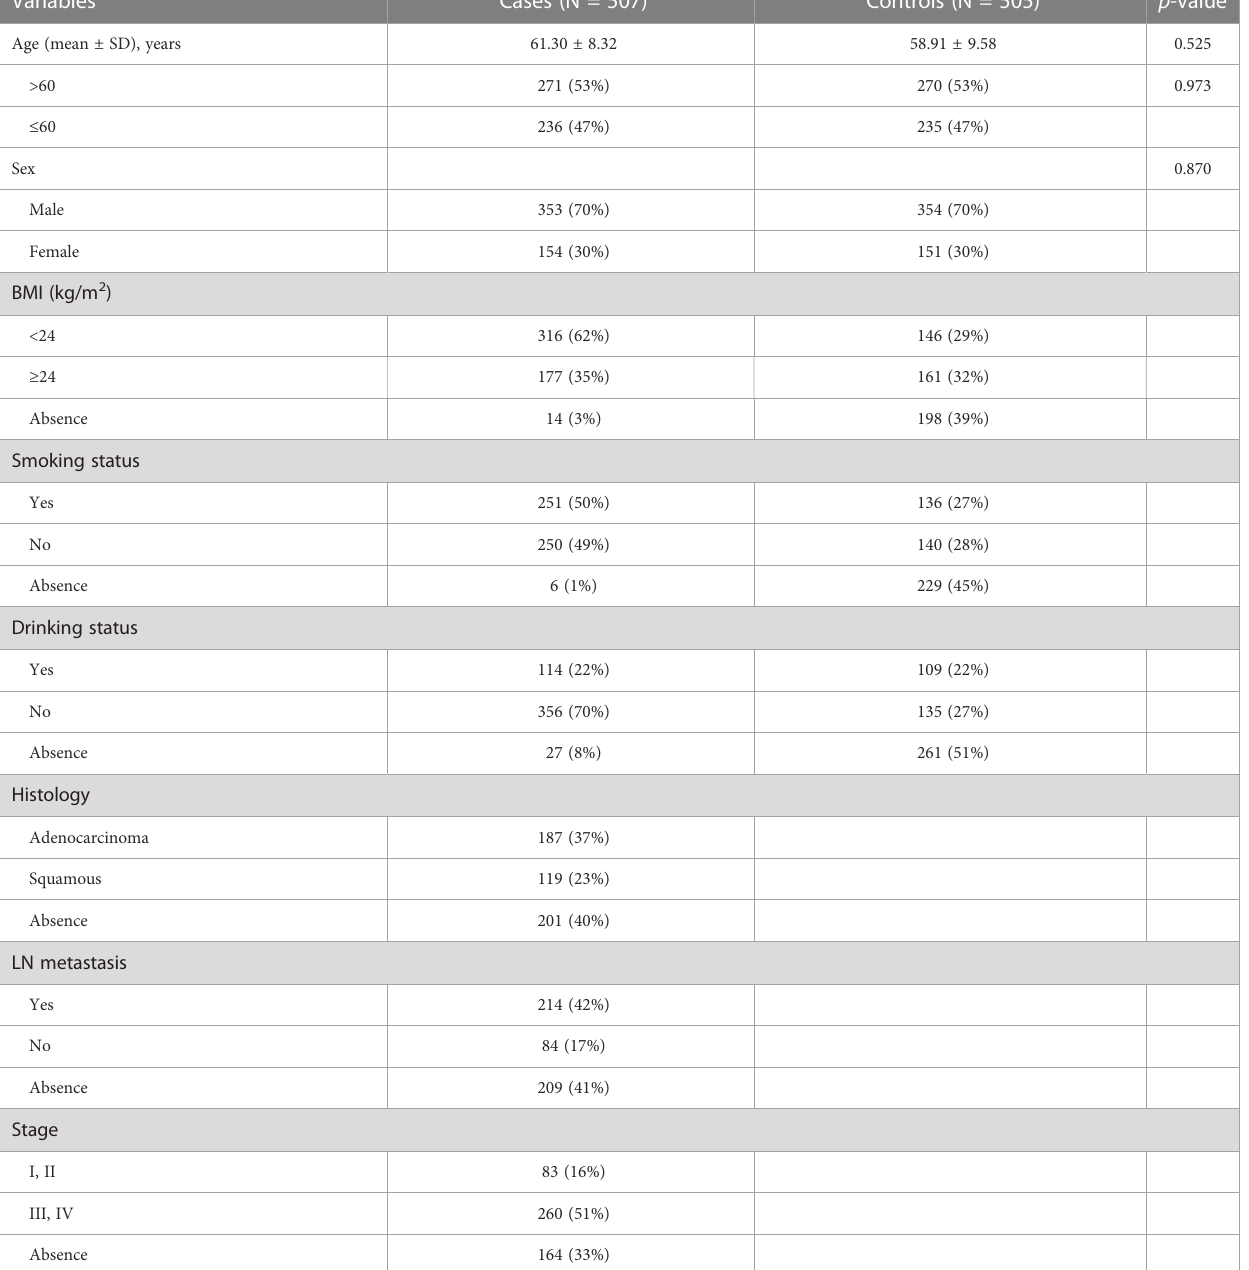
TABLE 1 Characteristics of patients with lung cancer and